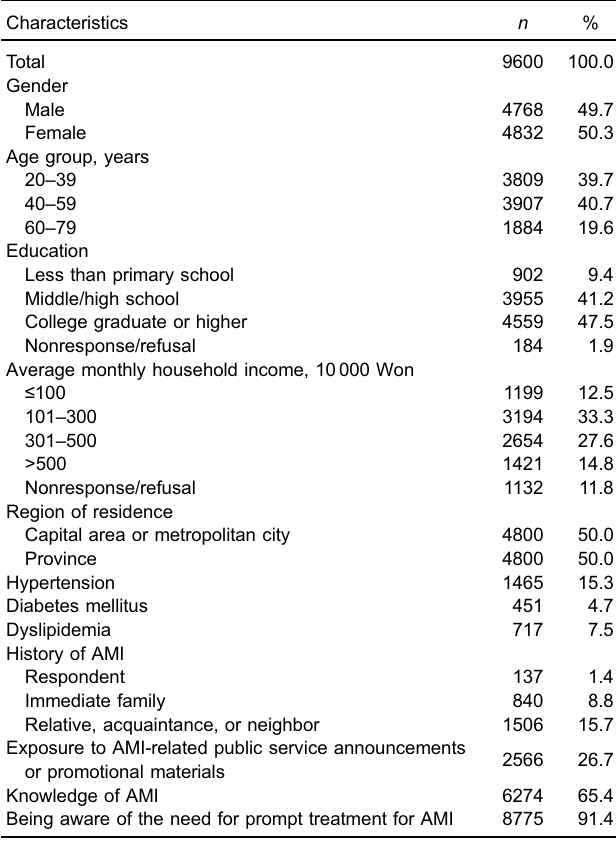
Table 1. General characteristics of respondents